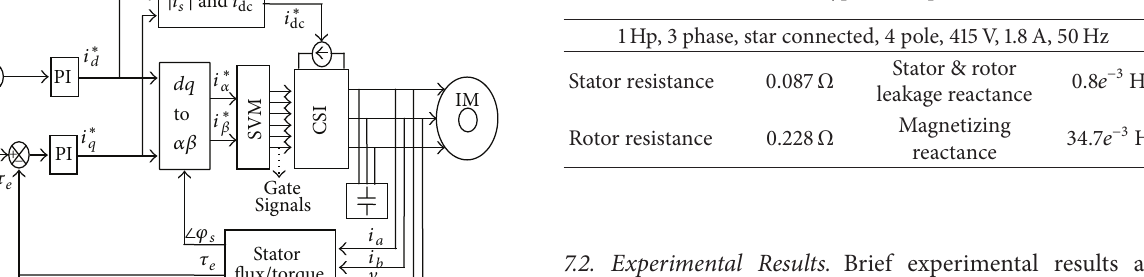
Table 1: Prototype motor